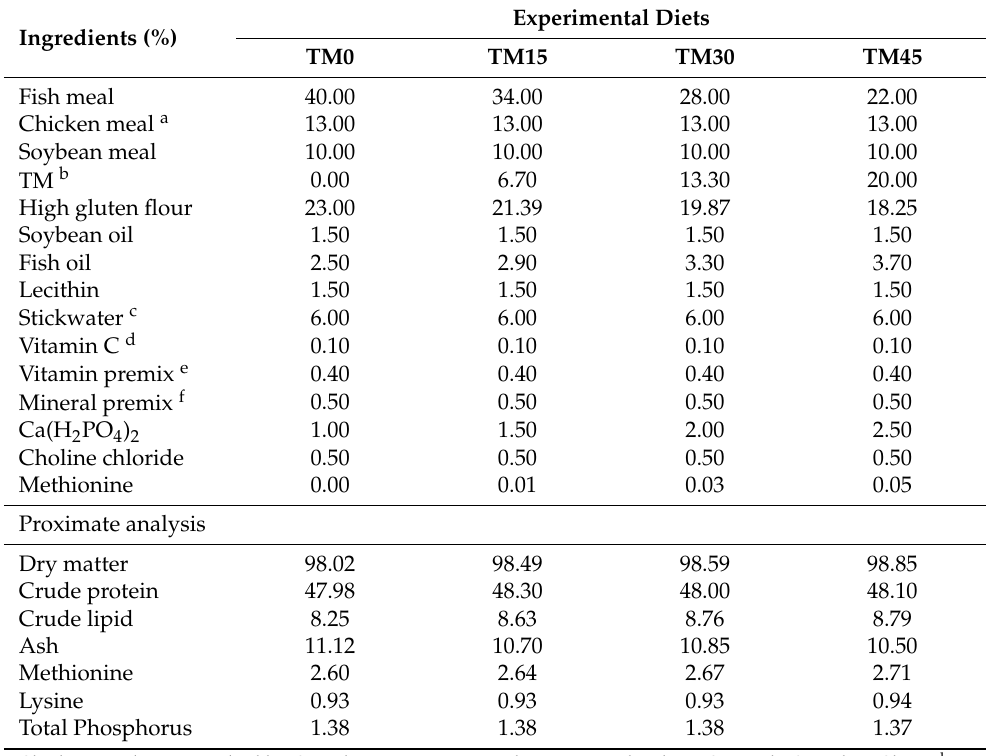
Table 2. Formulation and proximate composition of experimental diets (% dry matter). Ingredients